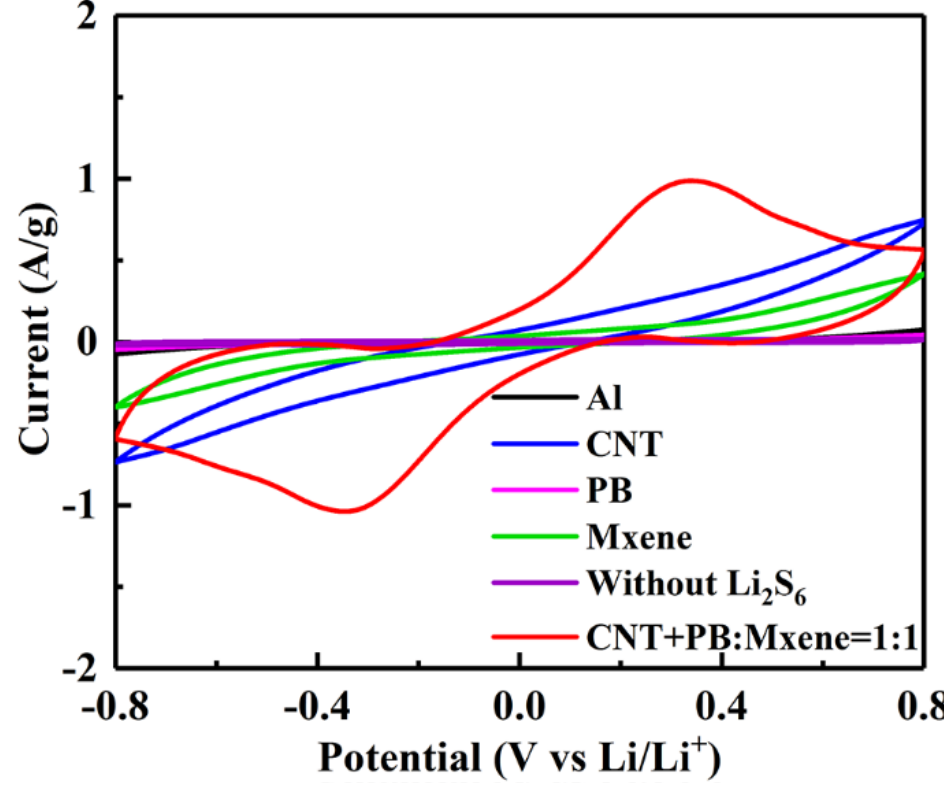
Figure 5. CV curves of symmetric LSBs at a scan rate of 10 mV s −1 with CNT, PB, Mxene, PB@Mxene and CNT+PB@Mxene as electrode materials.